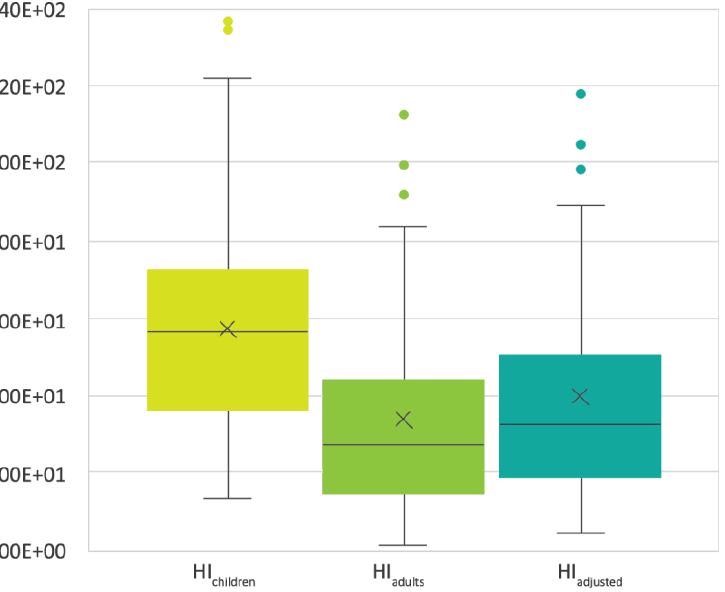
Figure 5. Hazard index for systemic toxicity for children and adults, as well as adjusted for both children and adults. children and